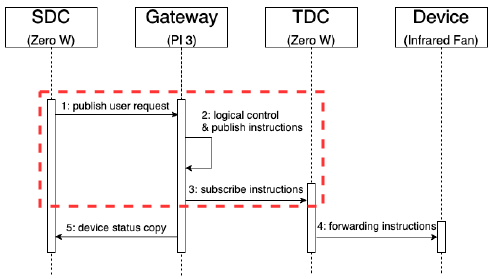
Figure 16. Timing sequence diagram of publish/subscribe between different devices by logical control. This process is to simulate the SDC to control a traditional device.